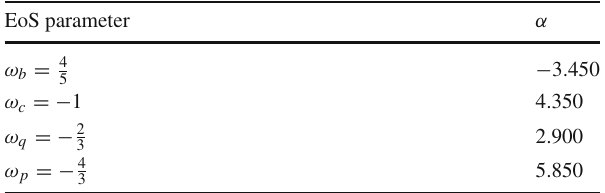
Table 3 The numerical values for α , taking into account different choices for the EoS parameter ω and for β = 0 . 45 ( km − 2 ) and r 0 = 1 ( km ) EoS parameter